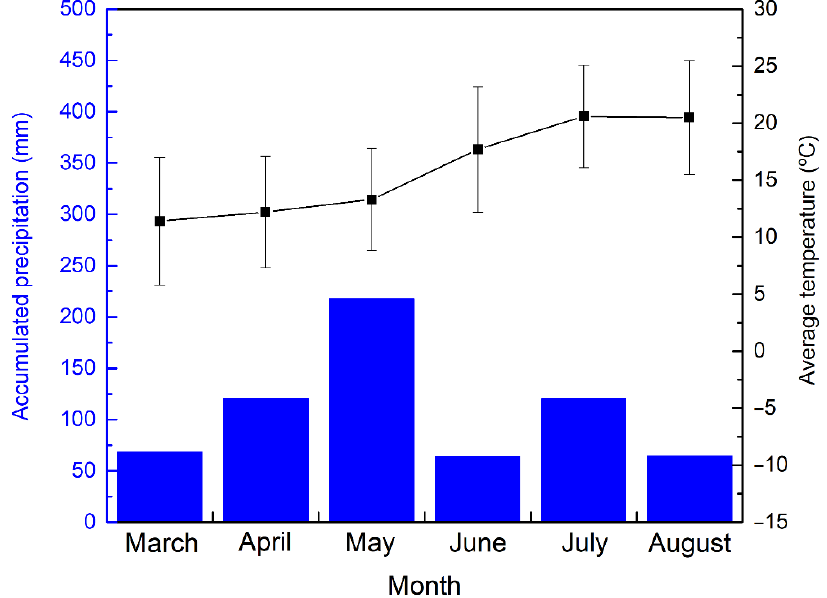
Figure 2. Graph showing the weather conditions during durability test EN 335 in Donostia/San Sebastian from March to August 2019.